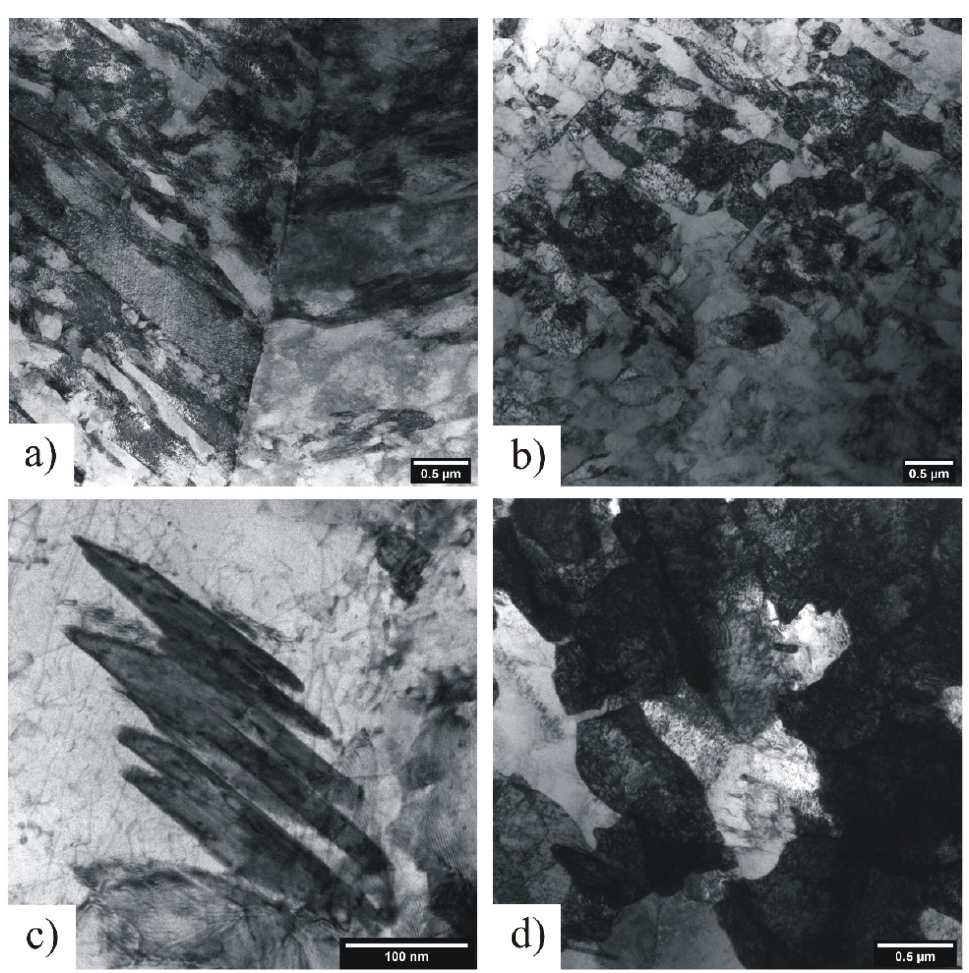
Figure 10. TEM bright-field images of X2-9: ( a , c ) In the reference condition and ( b , d ) in the precharged condition.